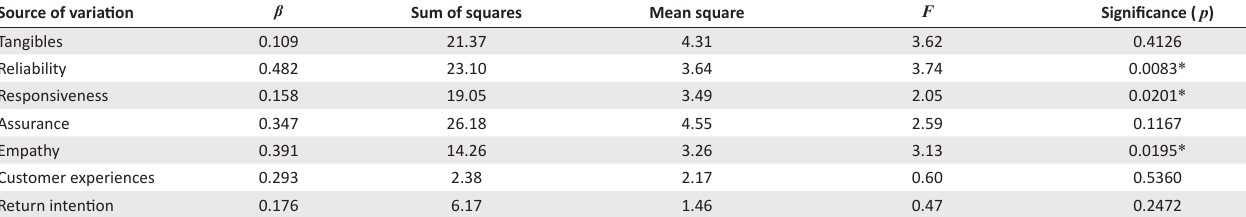
TABLE 6: Analysis of variance results for the five hotel dimensions, customer experiences and return intention in different hotels. Source of